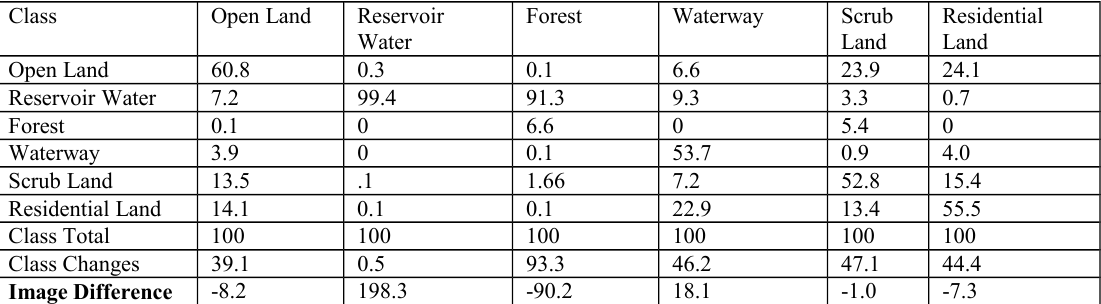
Table 3: Winter to Summer Season Change Detection